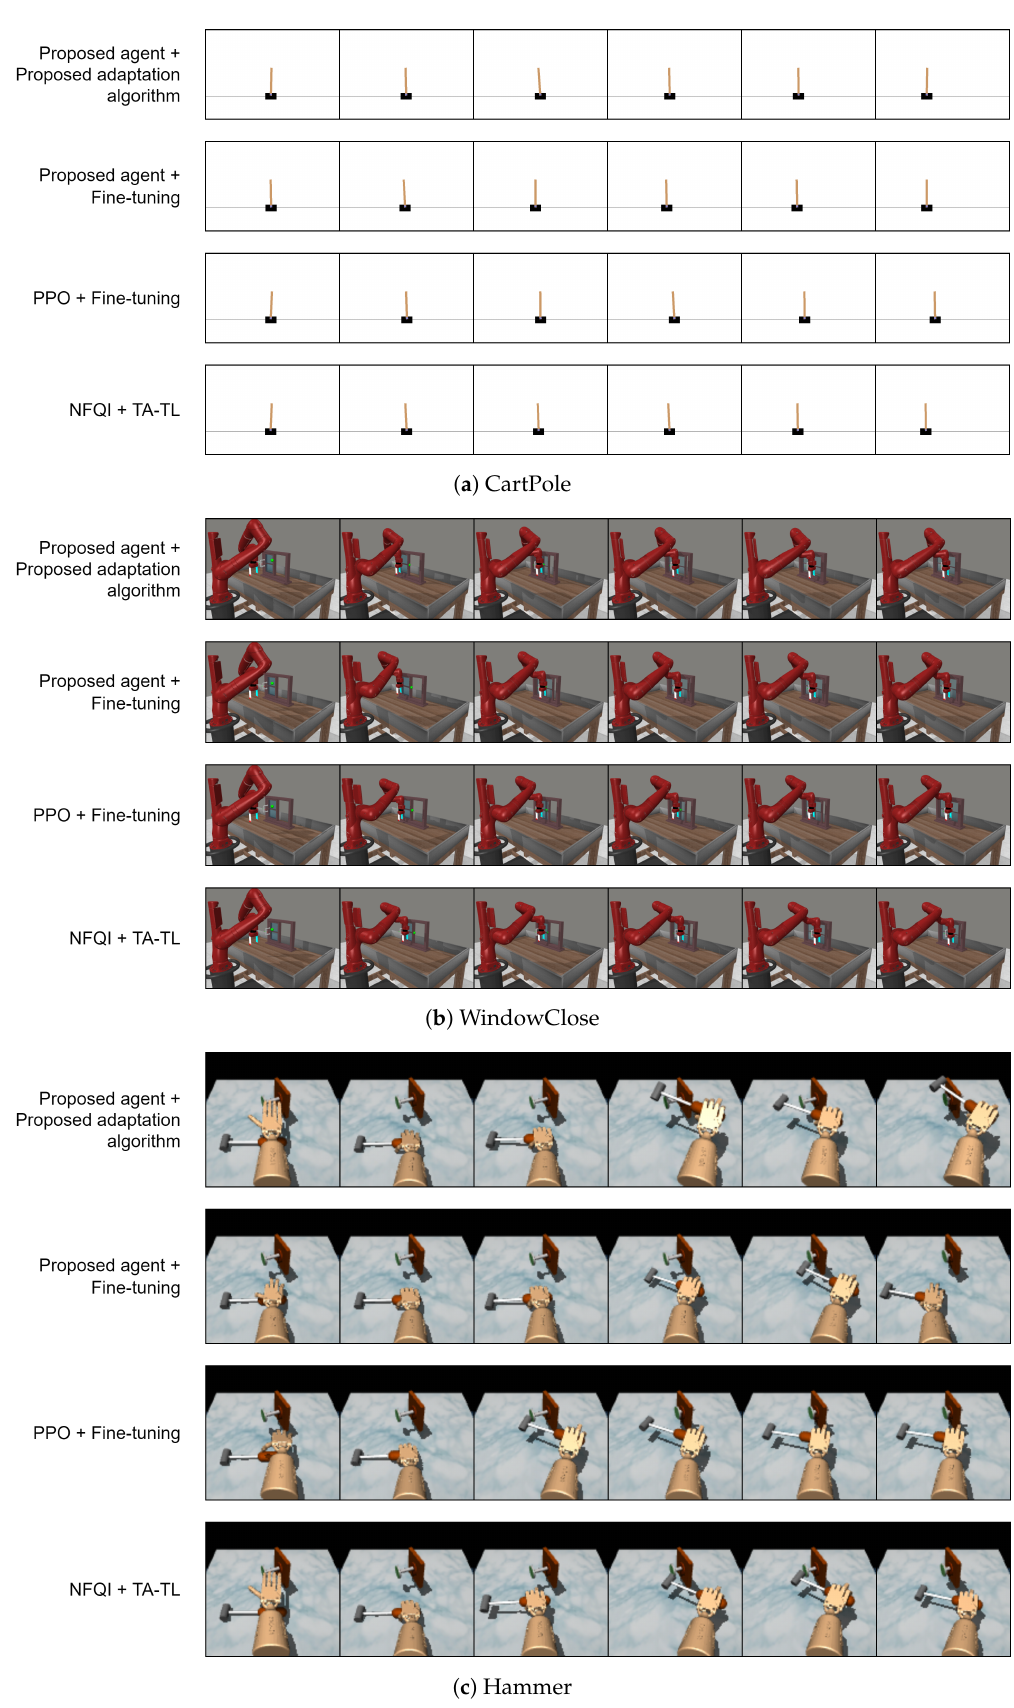
Figure 6. A visualization of the behavior of the proposed agent and baselines on target